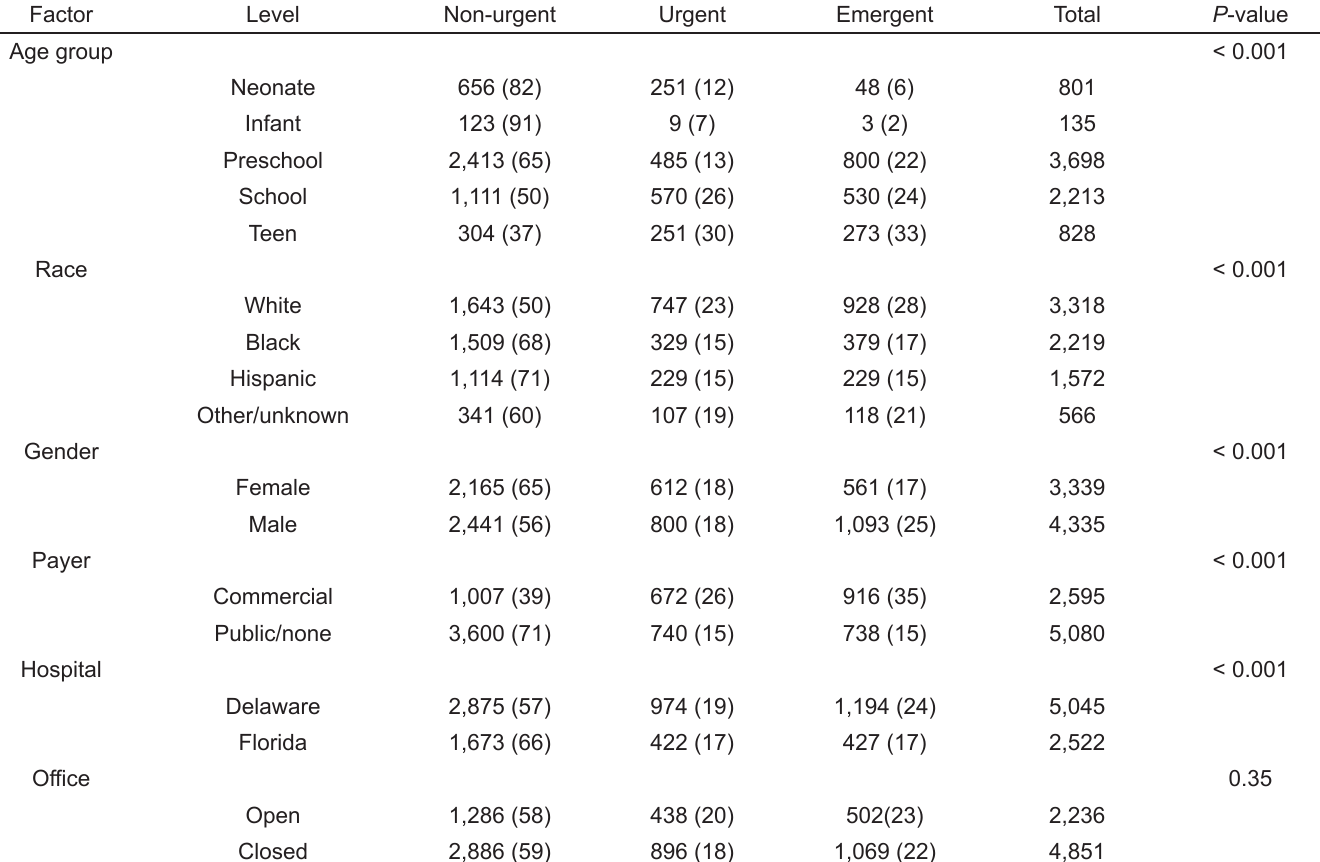
Table 2. Sample characteristics in relation to urgency of emergency department